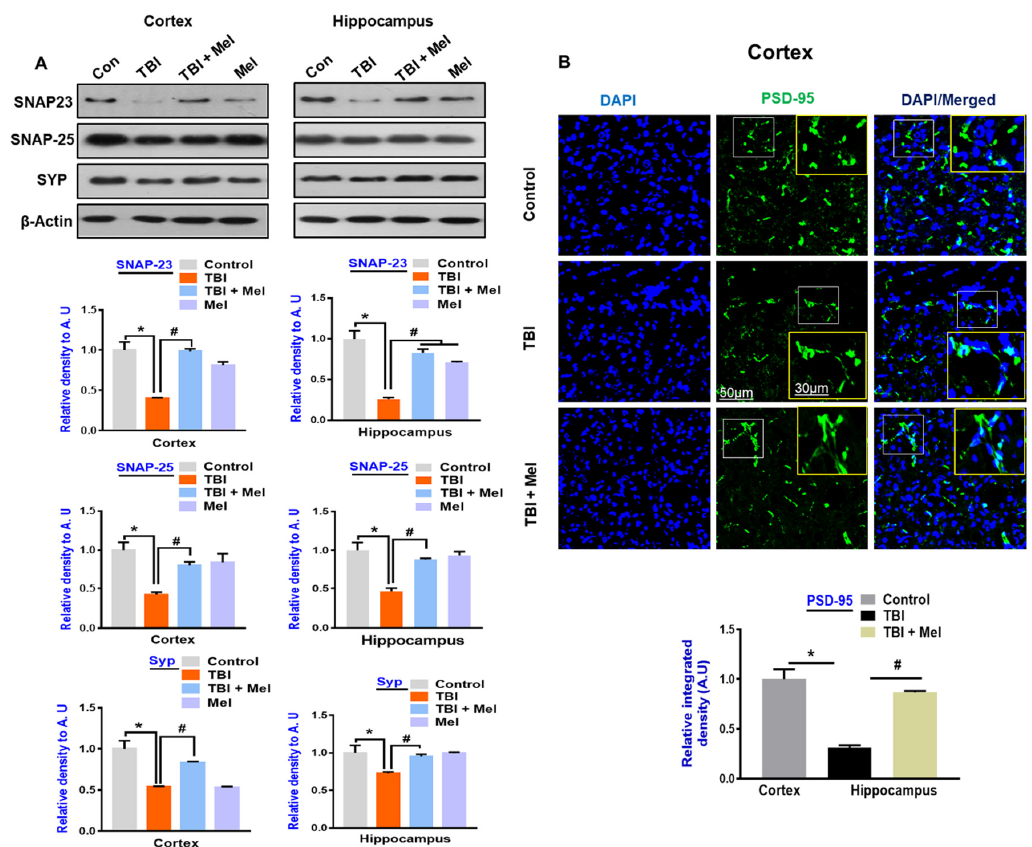
Figure 7 . Melatonin restores the depressed expression of synaptic markers in the traumatic brain injury (TBI) ‐ induced mouse brain. ( A ) Western blot results of SNAP ‐ 23, SNAP ‐ 25, and Synaptophysin in the ipsilateral cortex and hippocampus of the experimental groups, with respective bar graphs. (n = 10 mice per group). Beta ‐ actin was used as a loading control. SigmaGel software was used to analyze the data. ( B ) Confocal microscopic results of postsynaptic density protein ‐ 95 (PSD ‐ 95) expressions in the different experimental groups, with a respective bar graph. Magnification, 10×. n = 5 mice per group. Values were taken from three different experiments. The values are expressed as mean ± SEM. One ‐ way ANOVA followed by post ‐ hoc analysis. * p < 0.05 and ** p < 0.01 represent difference between control and repetitive mild traumatic brain injury (rmTBI), and # p < 0.05 and ## p < 0.01 represent difference between rmTBI plus melatonin (Mel) ‐ treated group.